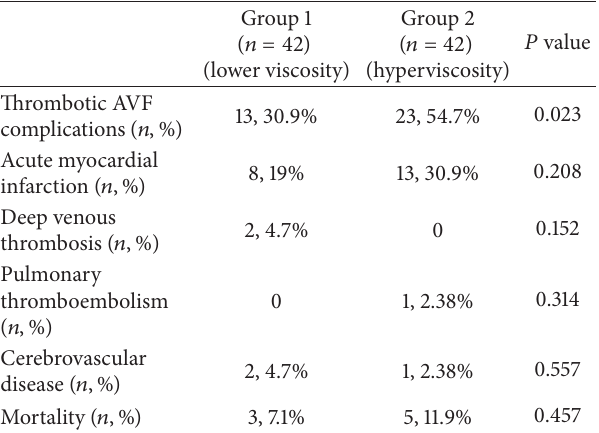
Table 3: Thrombotic complications and mortality of the study